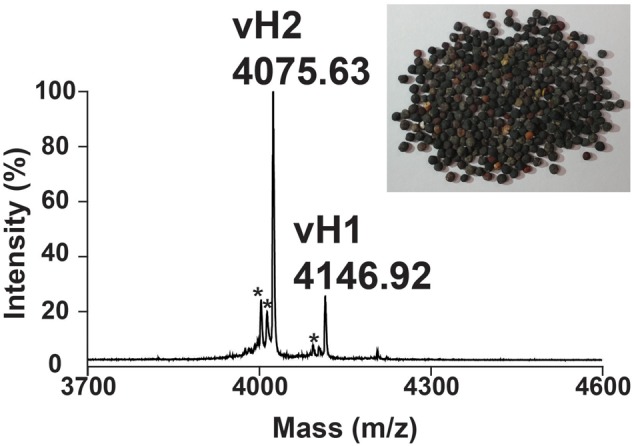
Mass spectrum of dried Vaccaria hispanica seeds. MALDI-TOF MS profile of the dried V. hispanica seeds extract in mass range of 3700–4600 Da. The dried V. hispanica seeds powder (1 g) was extracted with 5 mL of water. After centrifugation, the supernatant was fractionated using C18 Ziptip and eluted with 80% acetonitrile. ∗Unknown compounds. Further characterization is essential to determine the identifies of these compounds.